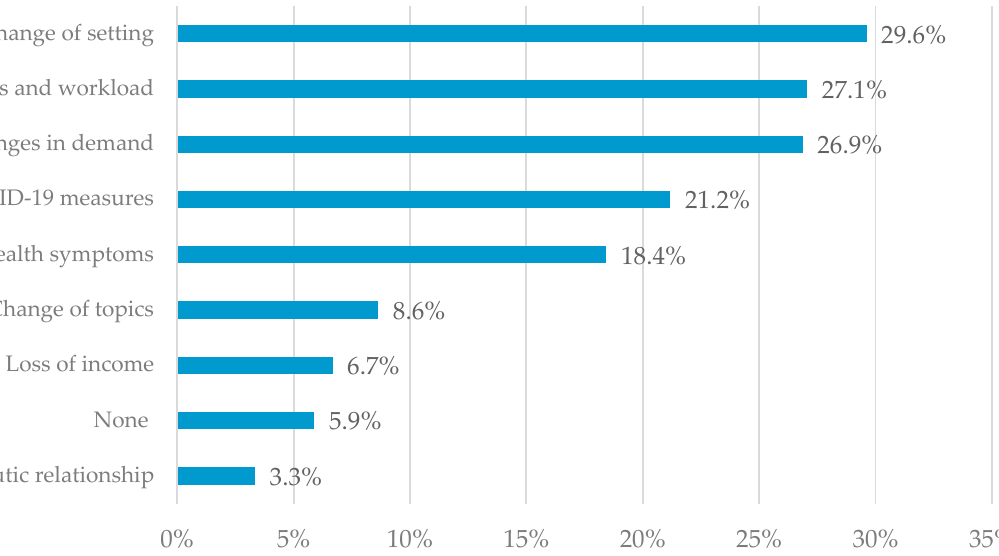
Figure 4. The proportion of patients treated on average per week via the telephone. LS Mean ± standard error.